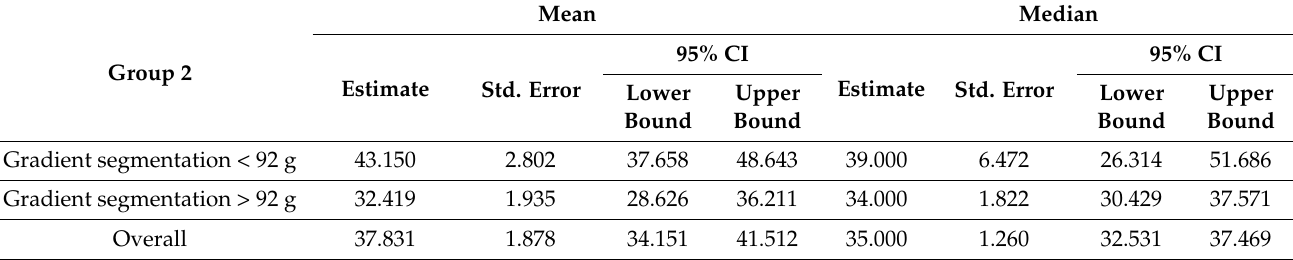
Table 6. Survival time means and